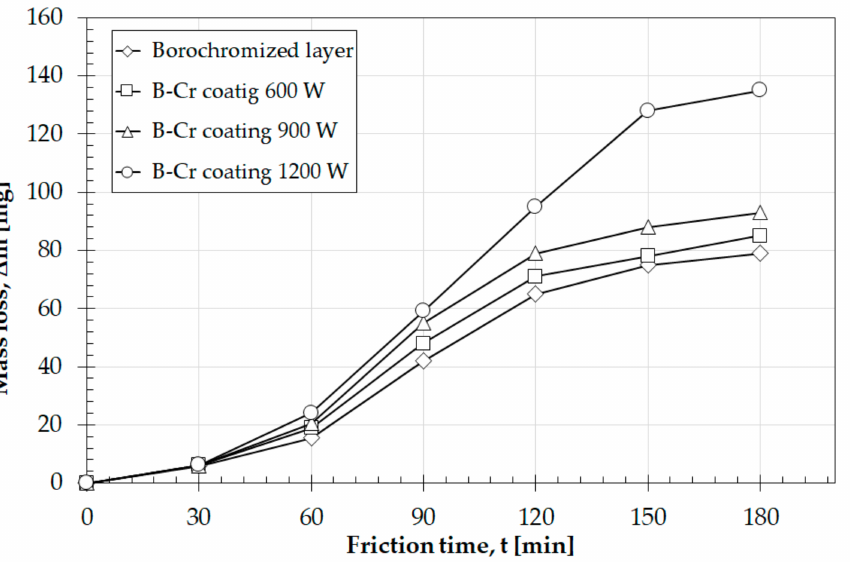
Figure 11. Wear resistance of diffusion borochromized layer and B-Cr coatings produced using laser